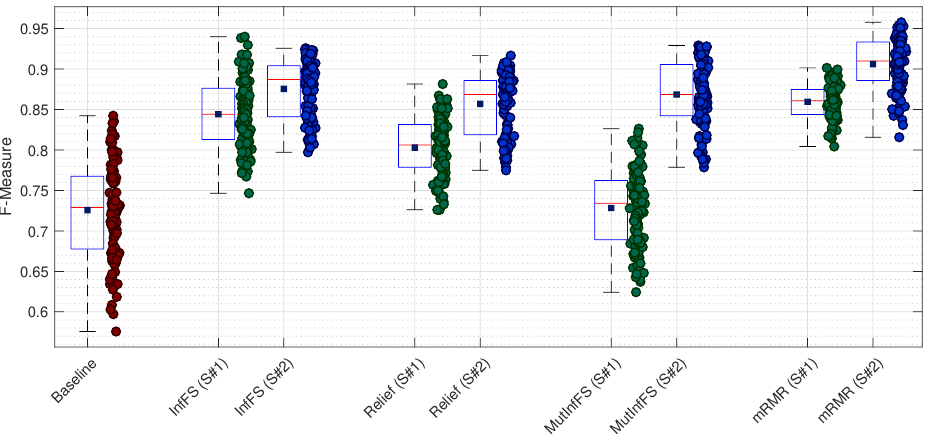
Figure 4. The attained F-measure values by means of the SVM classification model w.r.t. each